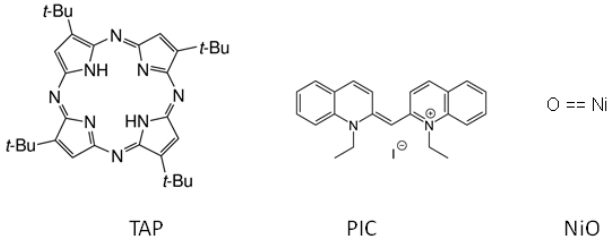
Figure 8. Structure of the three samples under investigation: TAP = tetra(tert-butyl)-porphyrazine), PIC = 1,1 ′ -diethyl-2,2 ′ -cyanine iodide and NiO = nickel